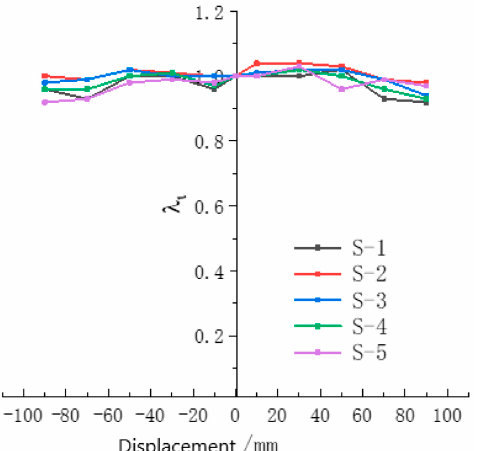
Figure 14. The strength degradation coefficient of S series joints varying with